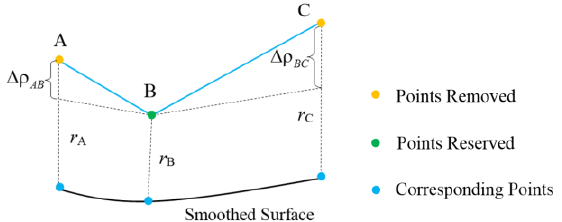
Figure 2. Stimulus variations generated by removing points